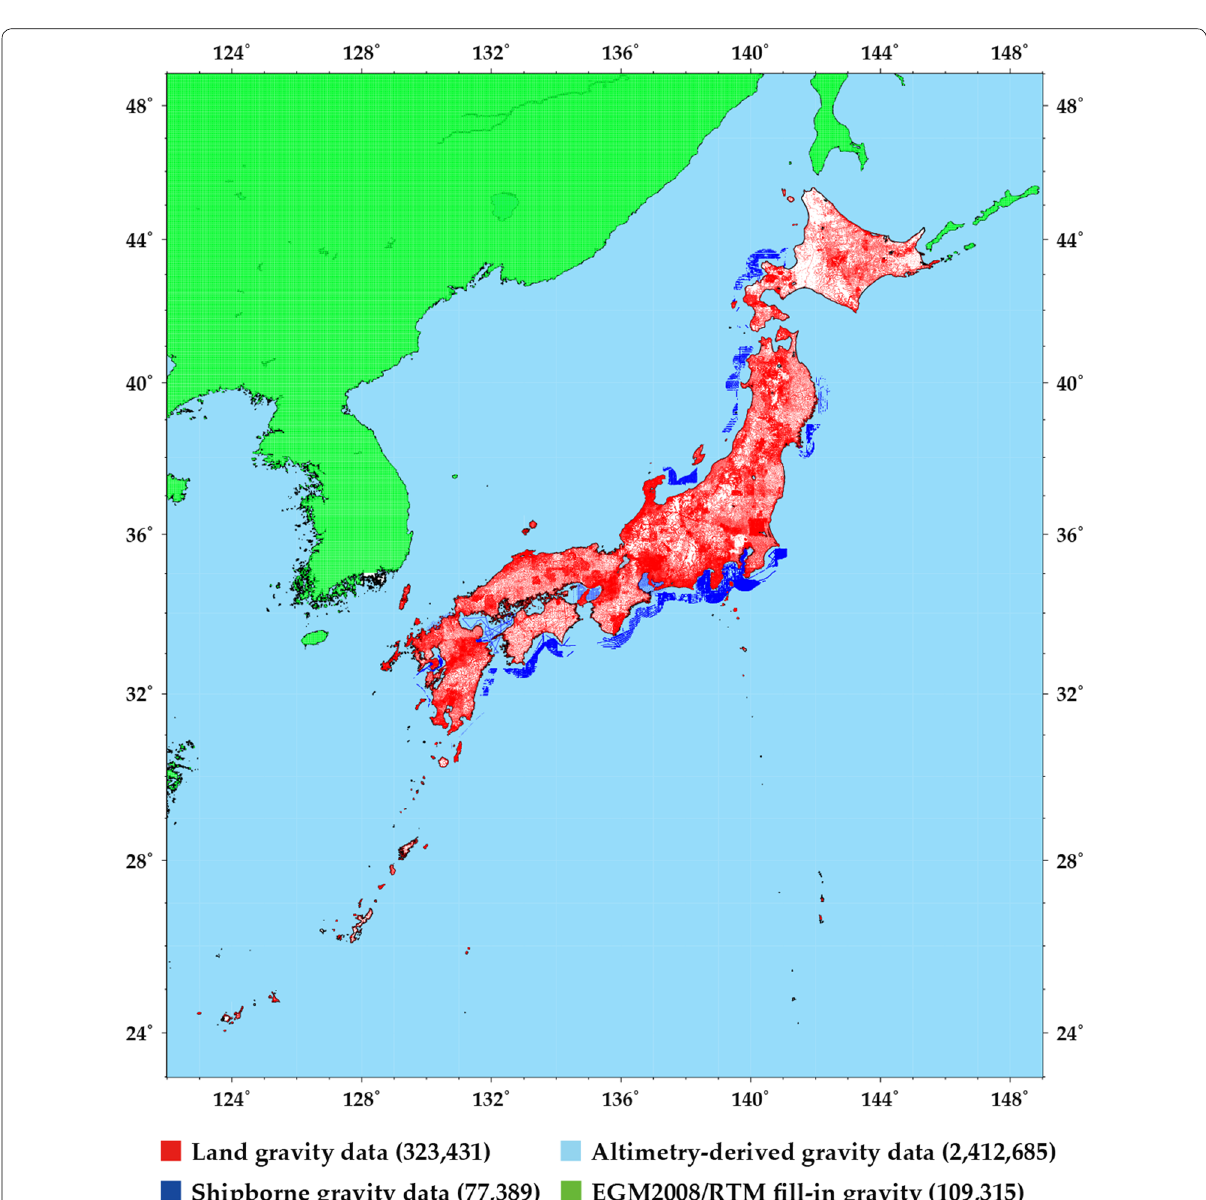
Fig. 2 Geographical distribution of terrestrial gravity data used in this study. The red dots are the land gravity data (323,431), the dark blue dots the shipborne gravity data (77,389), the light blue dots the altimetry-derived gravity data (2,412,685), and the light green dots EGM2008/RTM fill-in gravity data (109,315),